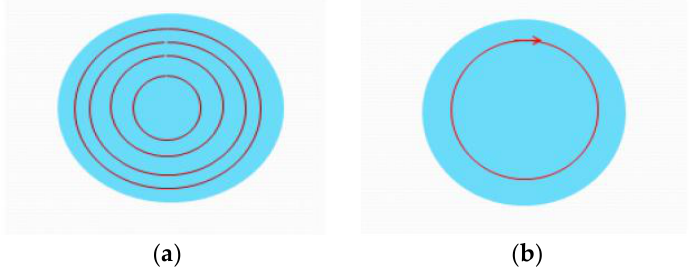
Figure 4. Schematic of laser paths: ( a ) Concentric circles; and ( b ) circle.